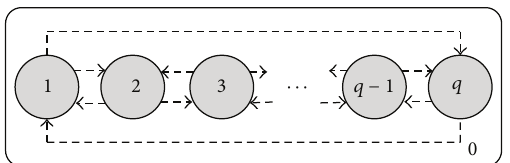
Figure 1: Membrane structure of the designed tissue-like P